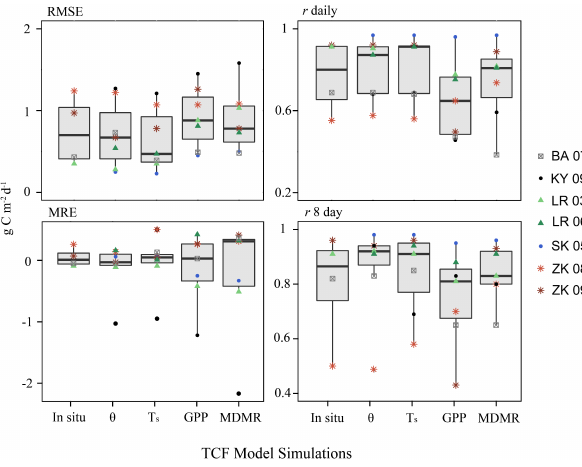
Fig. 5. TCF model accuracy for R eco relative to CO 2 records from five tower EC sites. The TCF model simulations include those de- termined from in situ measurement inputs; reanalysis soil moisture ( θ) , soil temperature ( T s ) or TCF LUE model simulated GPP inputs; TCF simulations derived entirely from remote sensing and reanaly- sis (MDMR) inputs. Measures of comparison include RMSE, MRE, r values for daily and 8 day cumulative fluxes. The BA 2009 results represent the local spatial mean determined from north, central and southern Barrow tower